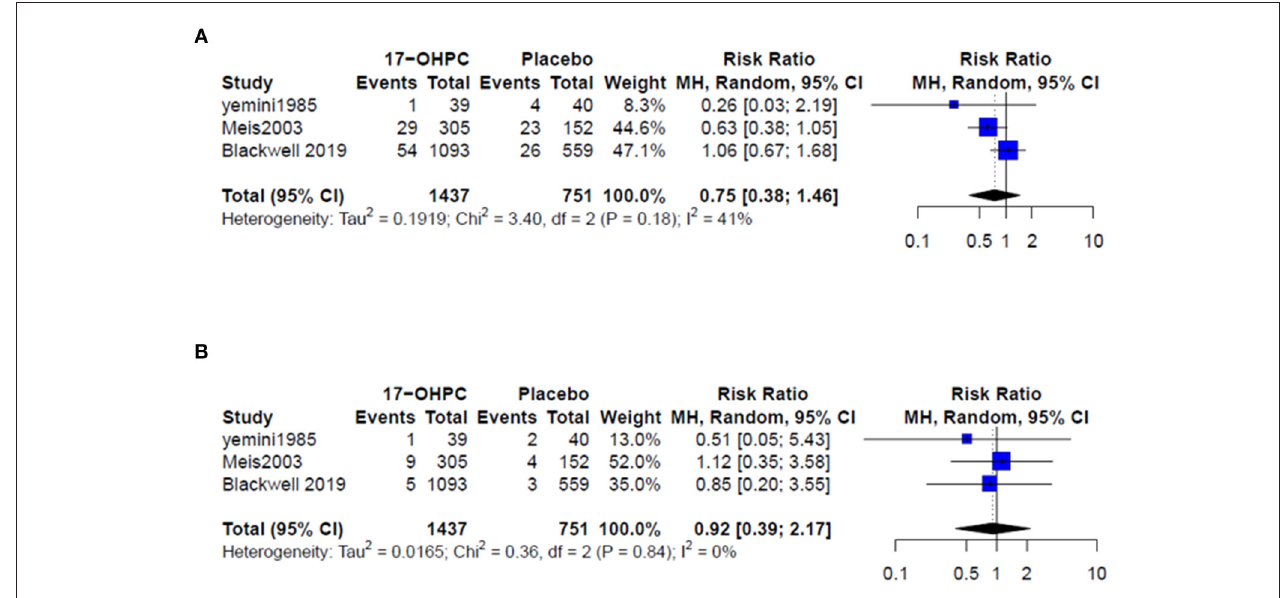
FIGURE 4 | Forest plots of the risks of (A) respiratory distress and (B) sepsis.